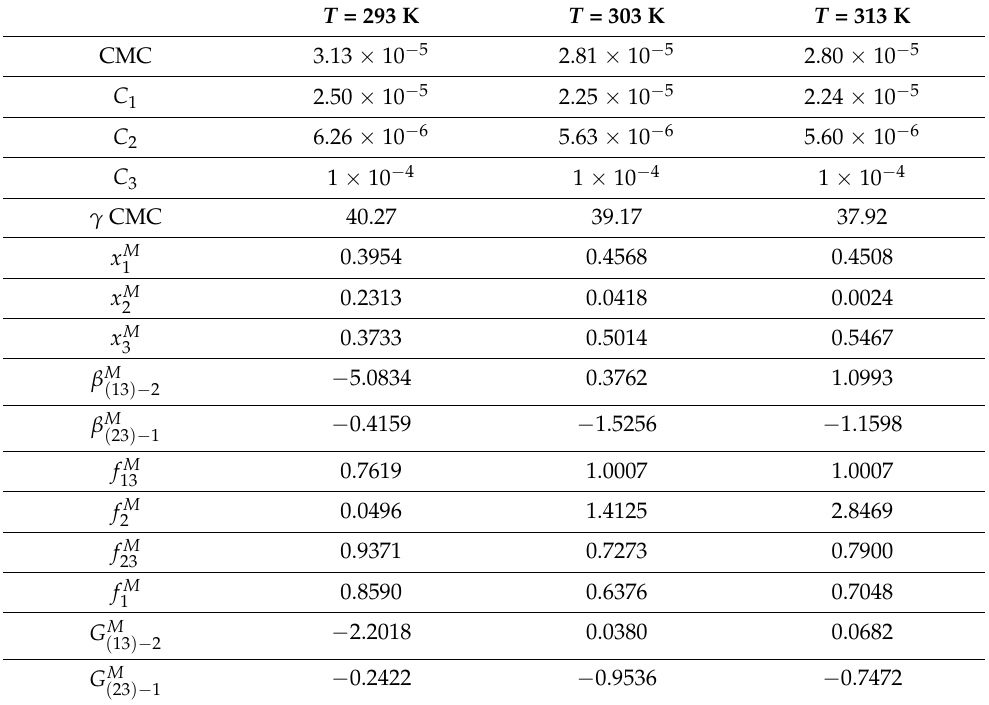
Table 3. The values of the fraction of area occupied by a component in the micelles in mixture M3 ( x M ), intermolecular interactions parameters for mixed micelle ( β M ) , activity coefficient ( f M ), and the excess Gibbs energy of micelle formation per mole of the surfactant mixture ( G M ) calculated from the Rosen and Hua concept (Equations (10)–(12), (24), (25) and (27)) at T = 293, 303, and 313 K (1—ELP, 2—RH40, 3—Ber). T = 293 K T = 303